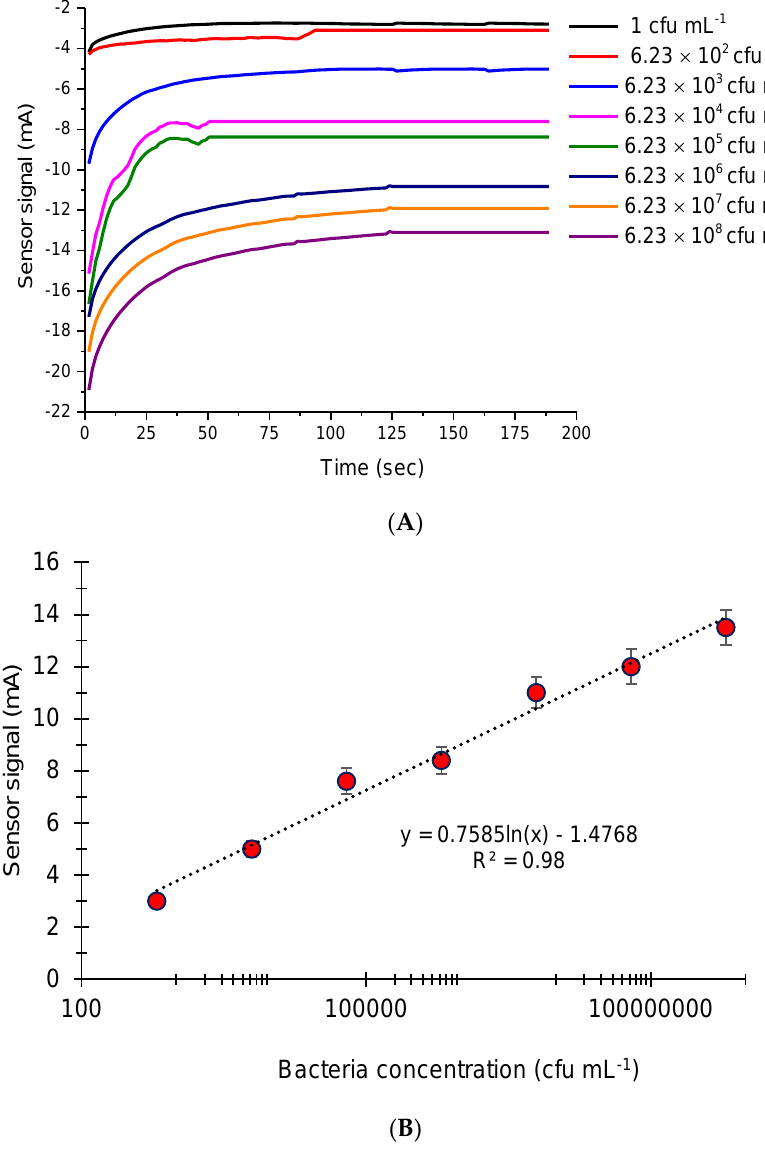
Figure 5. ( A ) The real-time measurement curves obtained for different concentrations of Y. enterocolitica in PBS buffer, using 5000 ppm GQDs as enzyme mimics. ( B ) Overall results of Y. enterocolitica detection in a concentration range of 6.23 × 10 2 – 6.23 × 10 8 cfu mL − 1 with an R 2 value of 0.98 (n = 3).